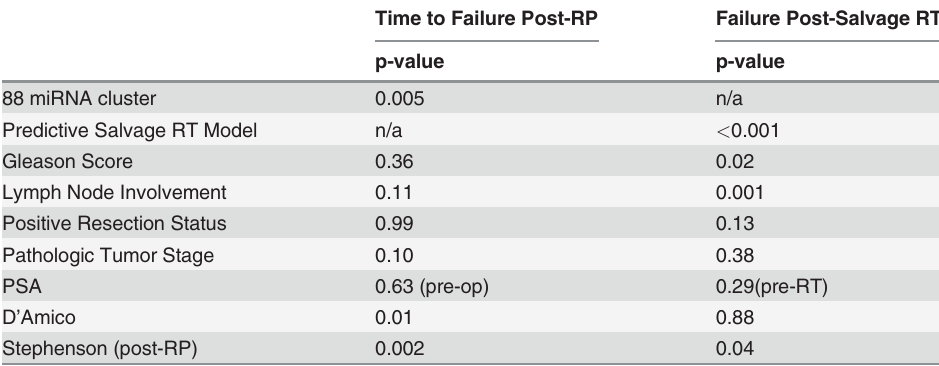
Table 2. Univariate analysis for molecular and clinical